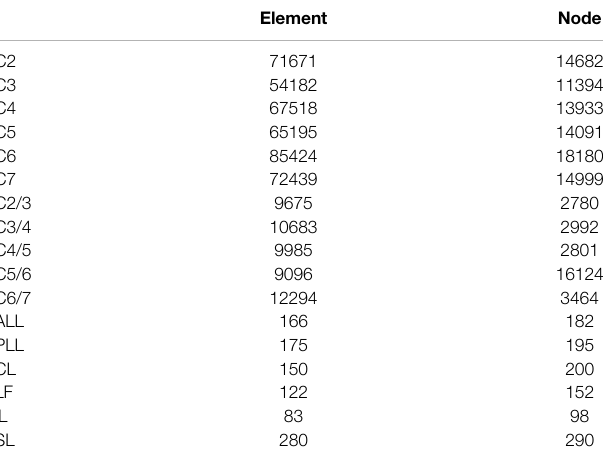
TABLE 2 | The number of elements and nodes for the cervical spine model.